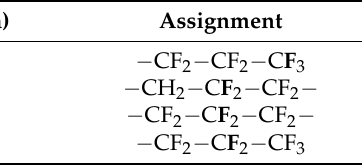
Table 5. Assignment of the chemical shift of 13 C{ 19 F}